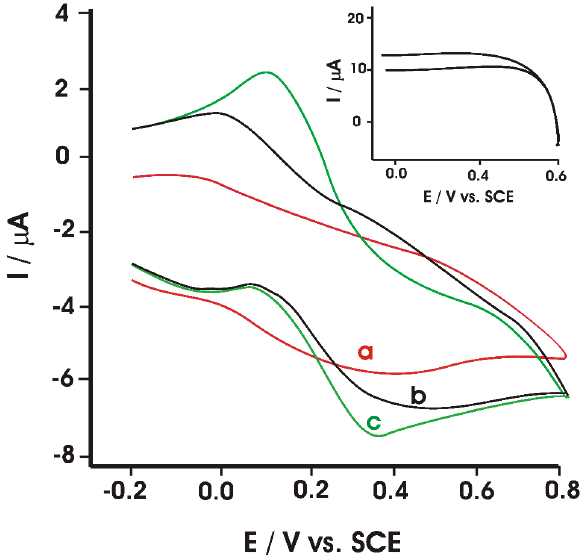
Figure 6. Cyclic voltammograms of chlorogenic acid at the bare GCE (a), UiO-66-NH 2 /GCE (b), and UiO-66-NH 2 /TiO 2 /GCE (c) in 0.1 mol L − 1 pH 6.0 PBS in the presence of chlorogenic acid. Scan rates: 100 mV·s − 1 . Inset: Cyclic voltammograms of the UiO-66-NH 2 /TiO 2 /GCE in 0.1 mol L − 1 PBS (pH 6.0) in the absence of chlorogenic acid. Adapted from [61]. Cyclic voltammograms of the sensor immersed in 10.0 µ mol · L − 1 CGA solution,